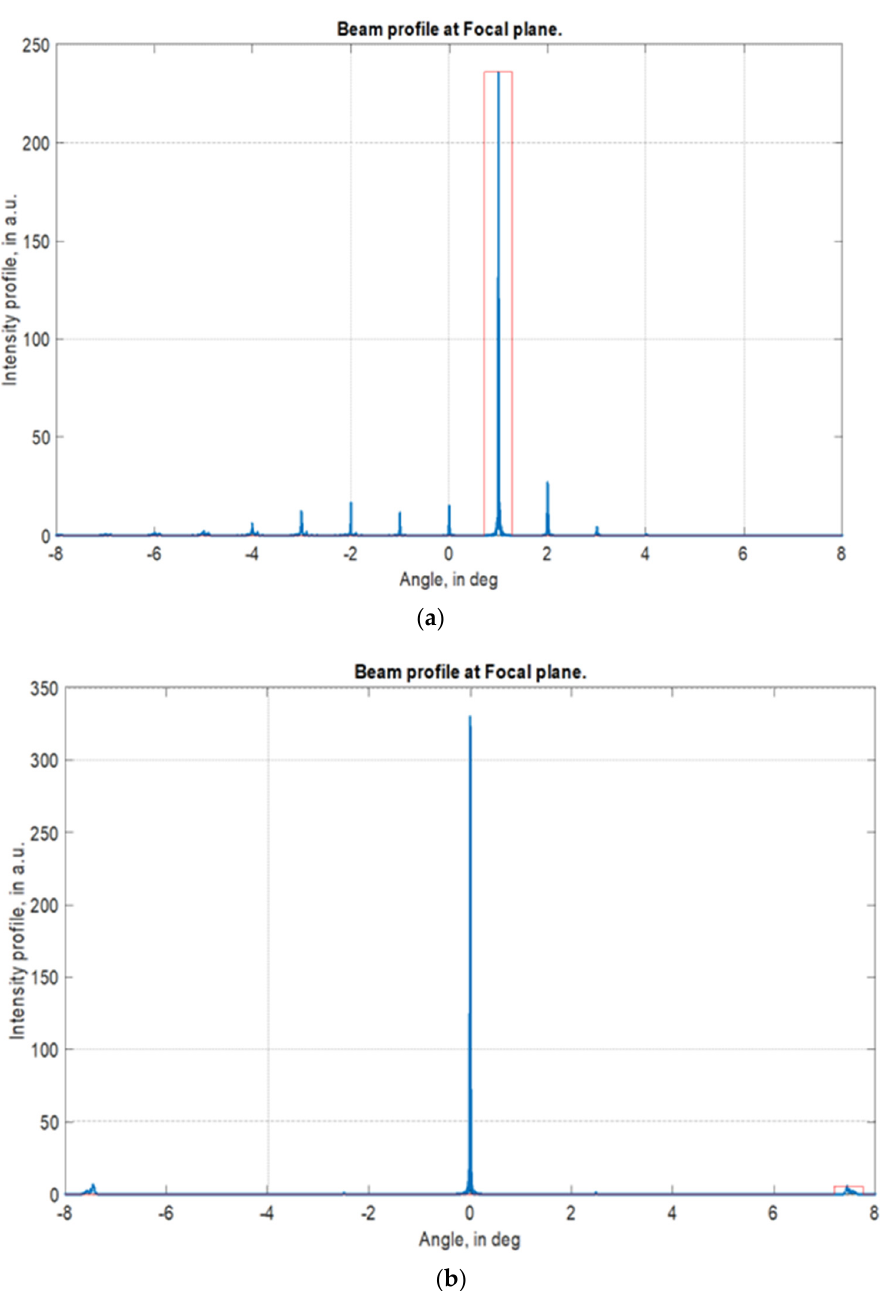
Figure 6. Beam profiles and DE values calculated for the full optical field. Simulation of the LC cell gap d = 2.5 μ m and the wavelength of the light source is λ = 520 nm. ( a ) Calculated first order DE is 61.5% at a diffraction angle of 1.5°; ( b ) calculated first order DE is 6.4% at a diffraction angle of 7.47°.